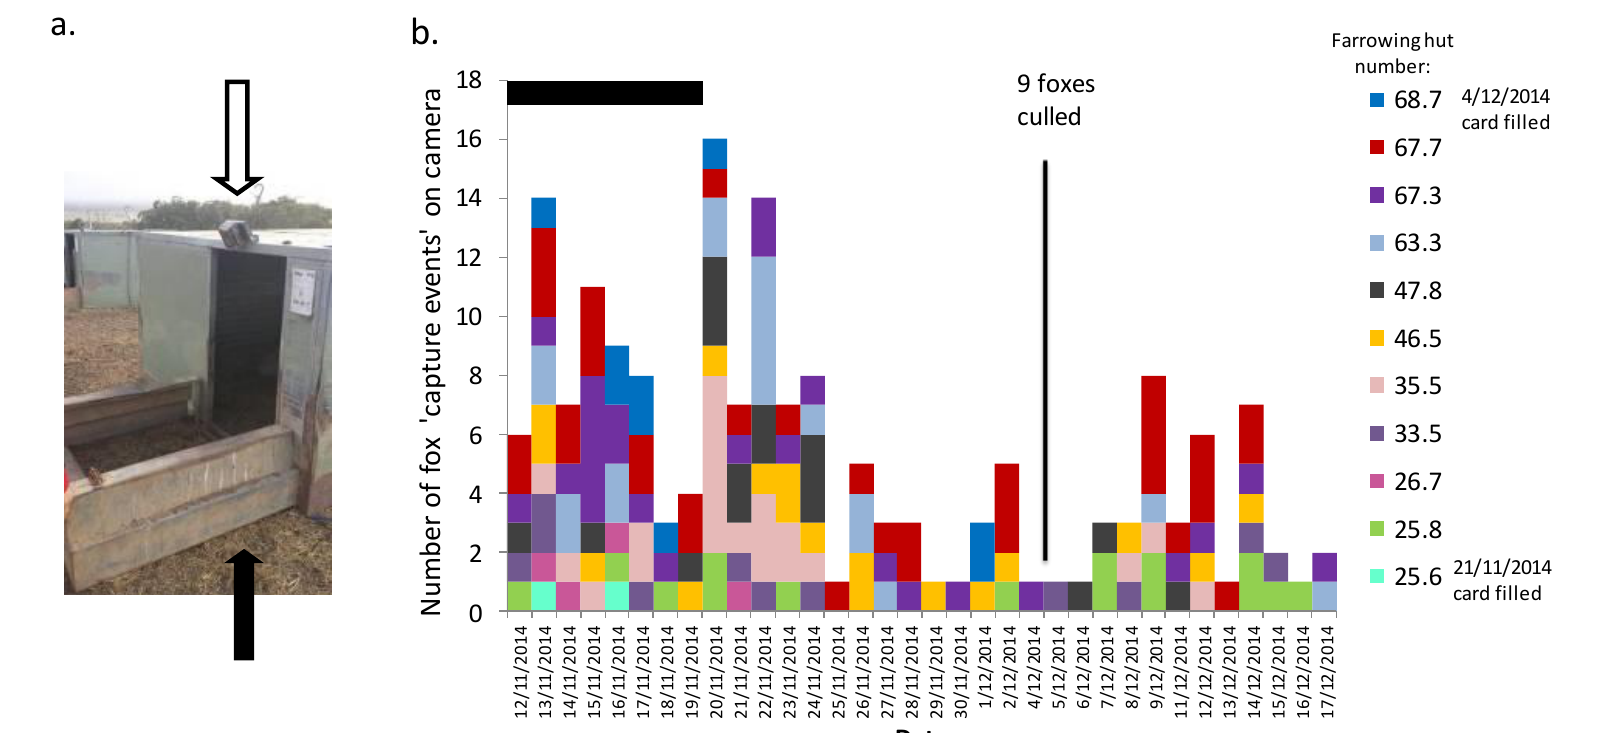
Figure 2. ( a ) Cameras mounted on 11 farrowing huts (white arrow shows camera; black arrow shows fenders that retain piglets within the huts for the first 10 days after they are born; ( b ) Numbers of capture events of foxes on farrowing hut cameras. The black bar above the graph indicates the time when fenders were in place. The numbers (key) identify the paddock and the hut within each paddock; two huts within paddock 67 and two within paddock 25 were monitored. The timing of a cull of nine foxes on the farm is indicated. Two cameras ran out of memory before the completion of the month—dates shown for these. The different colors reflect the individual huts monitored, and allow identification of where there are repeated visits to individual huts over consecutive nights.